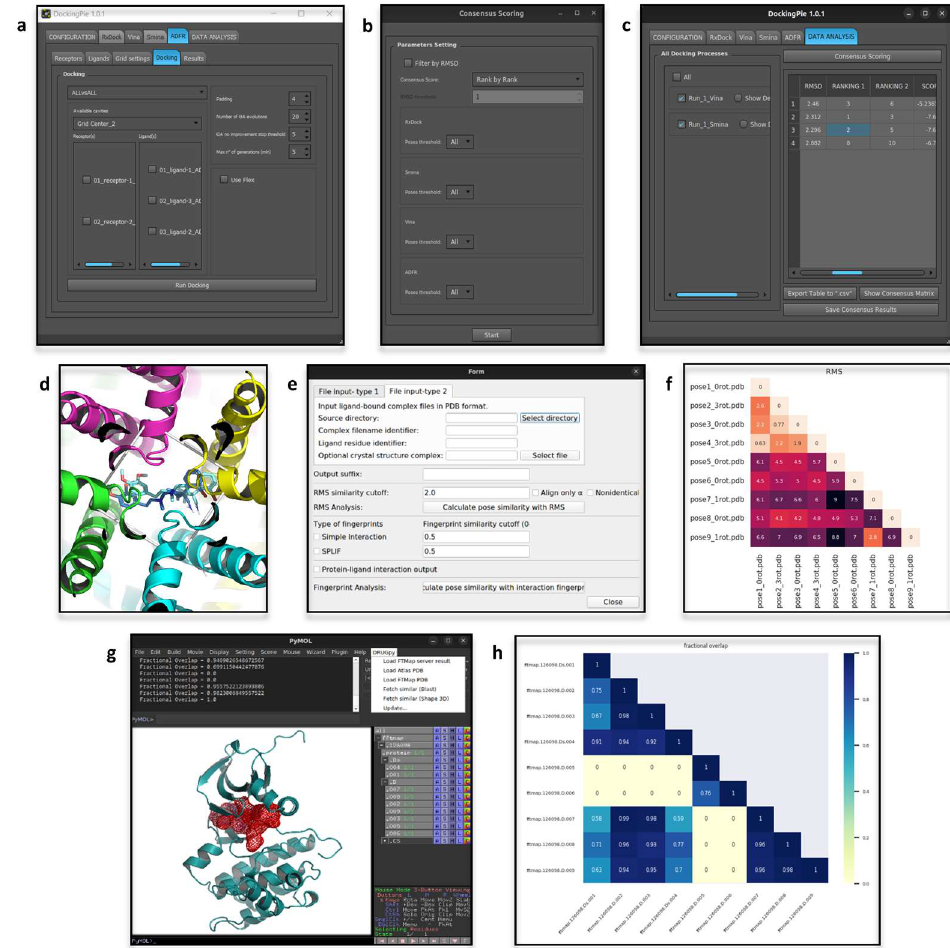
Figure 3. ( a ) DockingPie GUI (Windows OS) to set up an ‘all vs all’ MDo analysis with ADFR. ( b ) Appearance of the DockingPie windows (Ubuntu Linux OS) to run a consensus scoring analysis ( c ) and to inspect the results. In the latter, the re-scoring results are displayed in an interactive-table that can be clicked to directly visualize the molecules of interest in PyMOL ( d ). In this example, the re-scored poses were the results of two MDo runs carried out with Vina and Smina, from within DockingPie on a homo-tetrameric protein (PDB-ID: 5KMH [91]). ( e ) PoseFilter GUI to carry out either RMSD or interaction fingerprint comparison when a directory storing the objects to be analyzed as separated files (i.e., the protein and each conformation of the ligand) is provided. PoseFilter was used to analyze the MDo results obtained with DockingPie. ( f ) Heatmap of RMS values reporting the results of PoseFilter. ( g ) Visualization of the DRUGpy plugin and PyMOL workspace. The output data of a FTMap analysis on Aurora-A protein (PDB-ID: 1OL5 [36]) were loaded in DRUGpy for the analysis. DRUGpy automatically shows the identified hot-spots of interaction in PyMOL and, when a protein-ligand complex is analyzed, computes the fractional overlap analysis (shown as a heatmap ( h )).